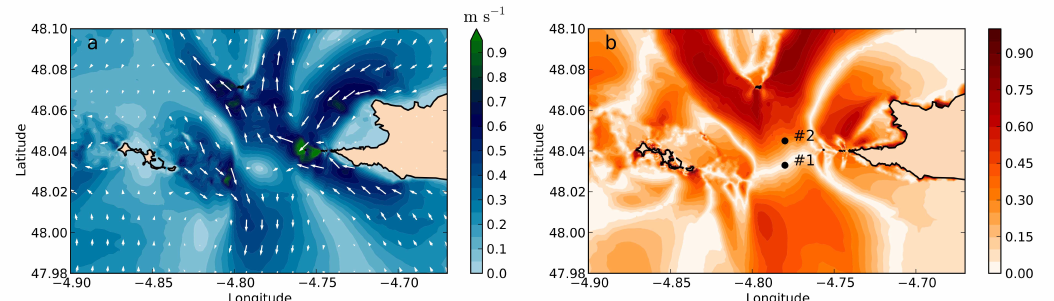
Figure 6. ( a ) Residual depth-averaged tidal currents and ( b ) parameter A characterizing the tidal current asymmetry during a mean spring tidal cycle. The black circles in Figure 6b show the locations of Points #1 and #2.